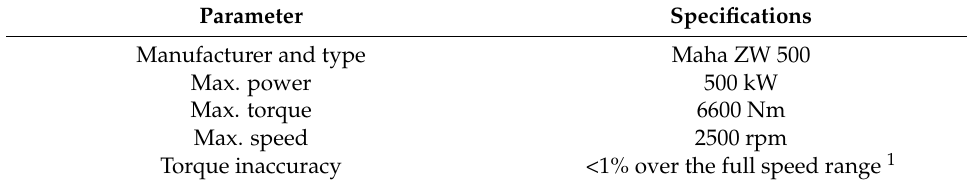
Table 4. Dynamometer specifications.